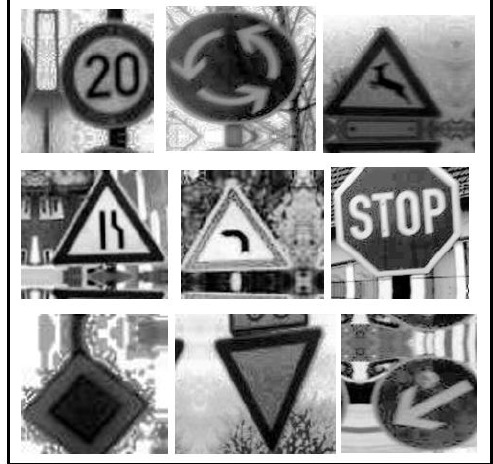
Figure 4. Sample images of the GTSRB